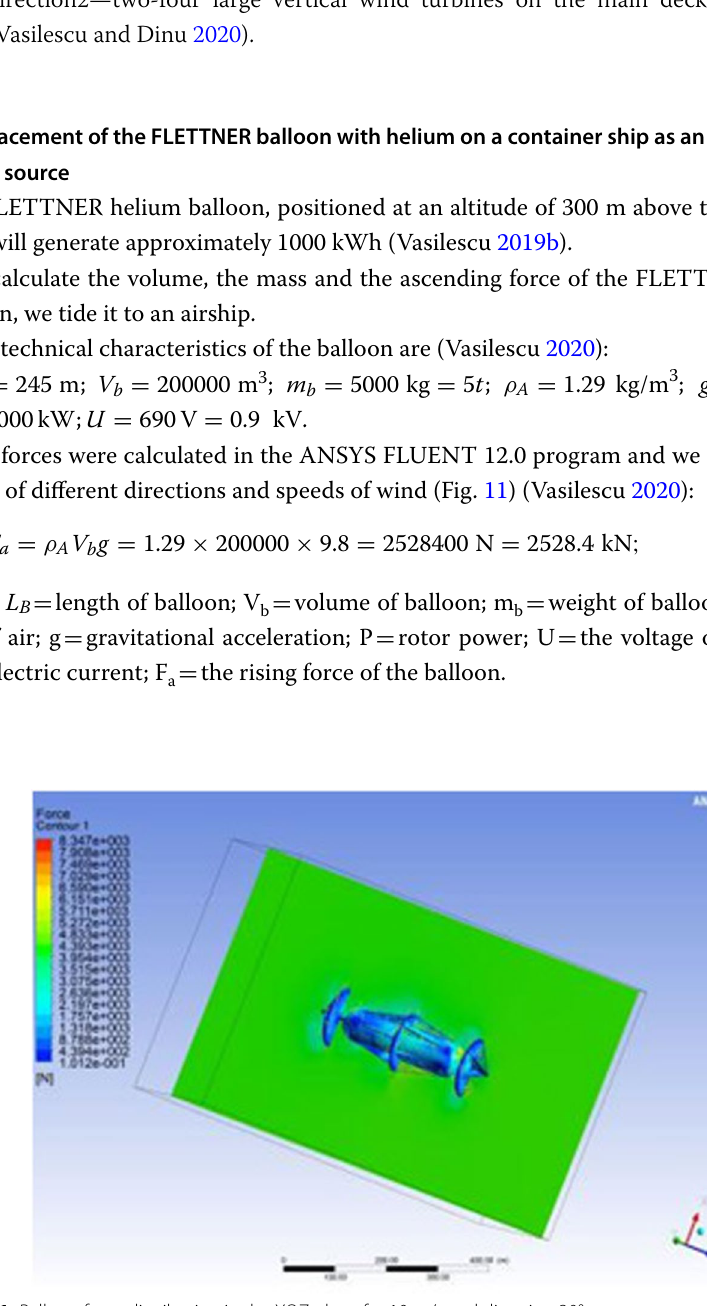
Fig. 11 Balloon force distribution in the XOZ plane for 10 m/s and direction